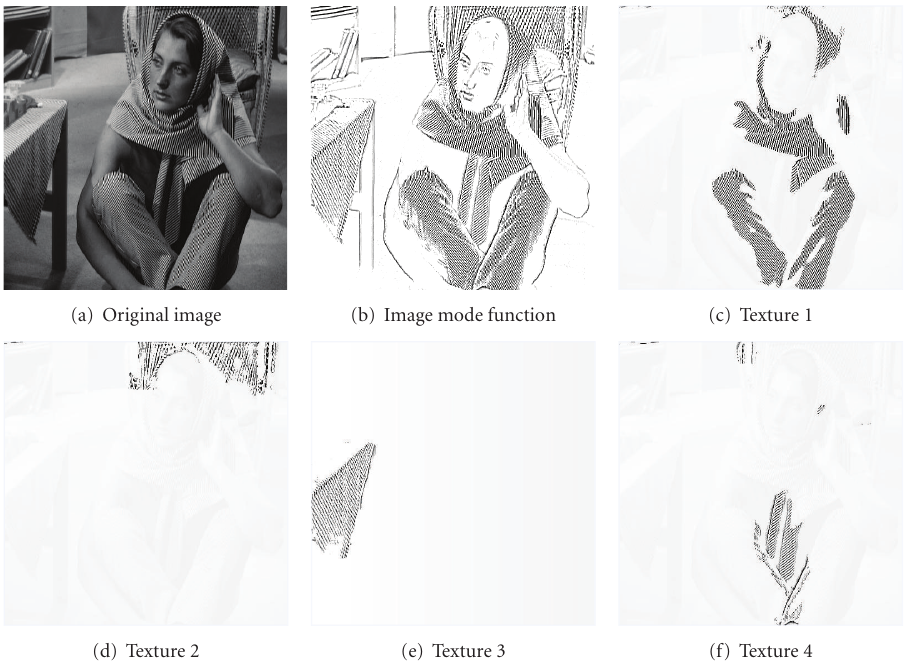
Figure 5: PDE transform is applied on (a) to extract edges of all textures into 5(b). Adaptive PDE transform is then applied to extract di ff erent textures from 5(b). In 5(c)–5(f), all the textures are superimposed on the original image for better viewing.